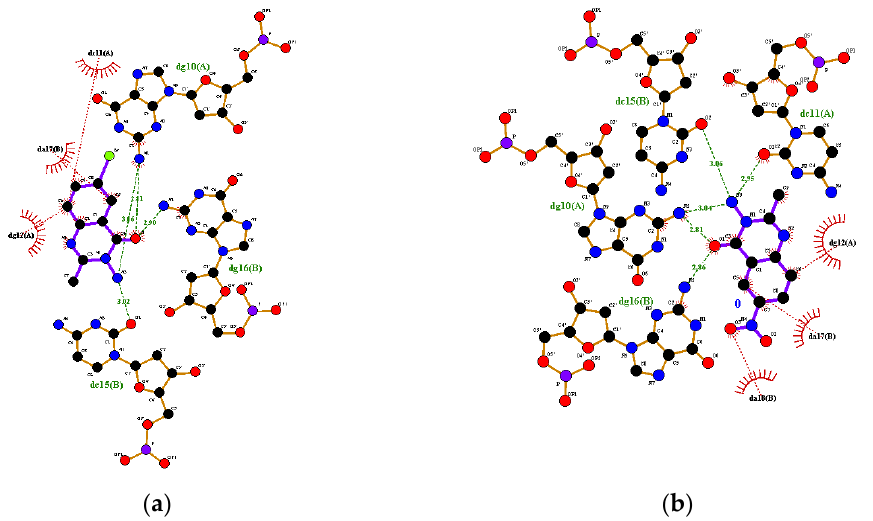
Figure 8. Panel ( a ): 2D Molecular Interactions for compound 3g ; Panel ( b ): 2D Molecular Interactions for compound 3j .